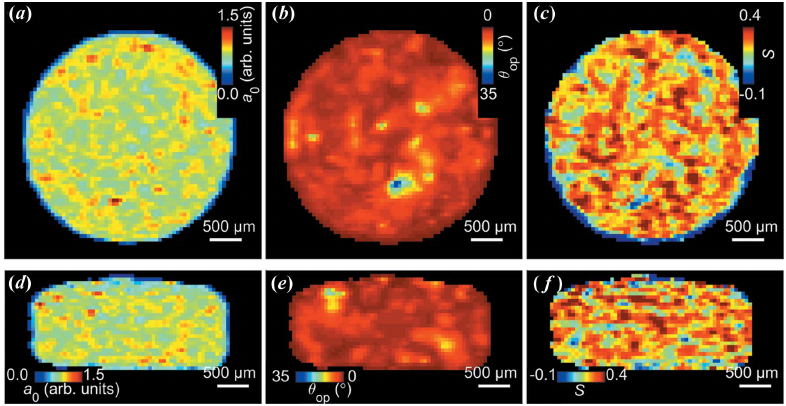
Figure 4 Reconstructed XRDTT orthogonal cross sections of the overlapping clinochlore 002/ kaolinite 002 Bragg peaks. ( a ), ( d ) Isotropic scattering a 0 . ( b ), ( e ) Directionality of scattering relative to the tomography axis. ( c ), ( f ) The reconstructed Hermans’ parameter S , cf. equation